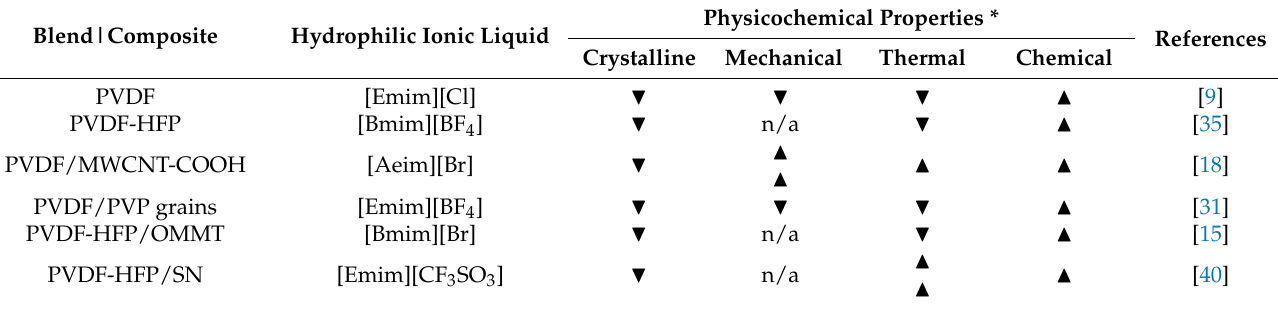
Table 7. Physicochemical properties of PVDF/and PVDF-HFP/hydrophilic imidazolium-based ionic liquid blends and composites. Blend|Composite Hydrophilic Ionic Liquid